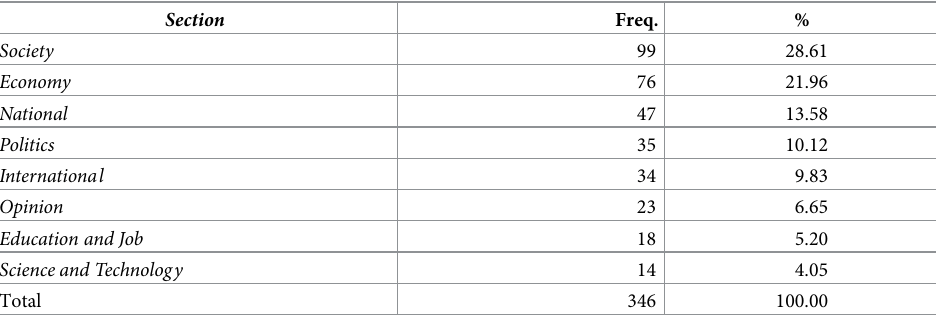
Table 8. Distribution of articles by section.